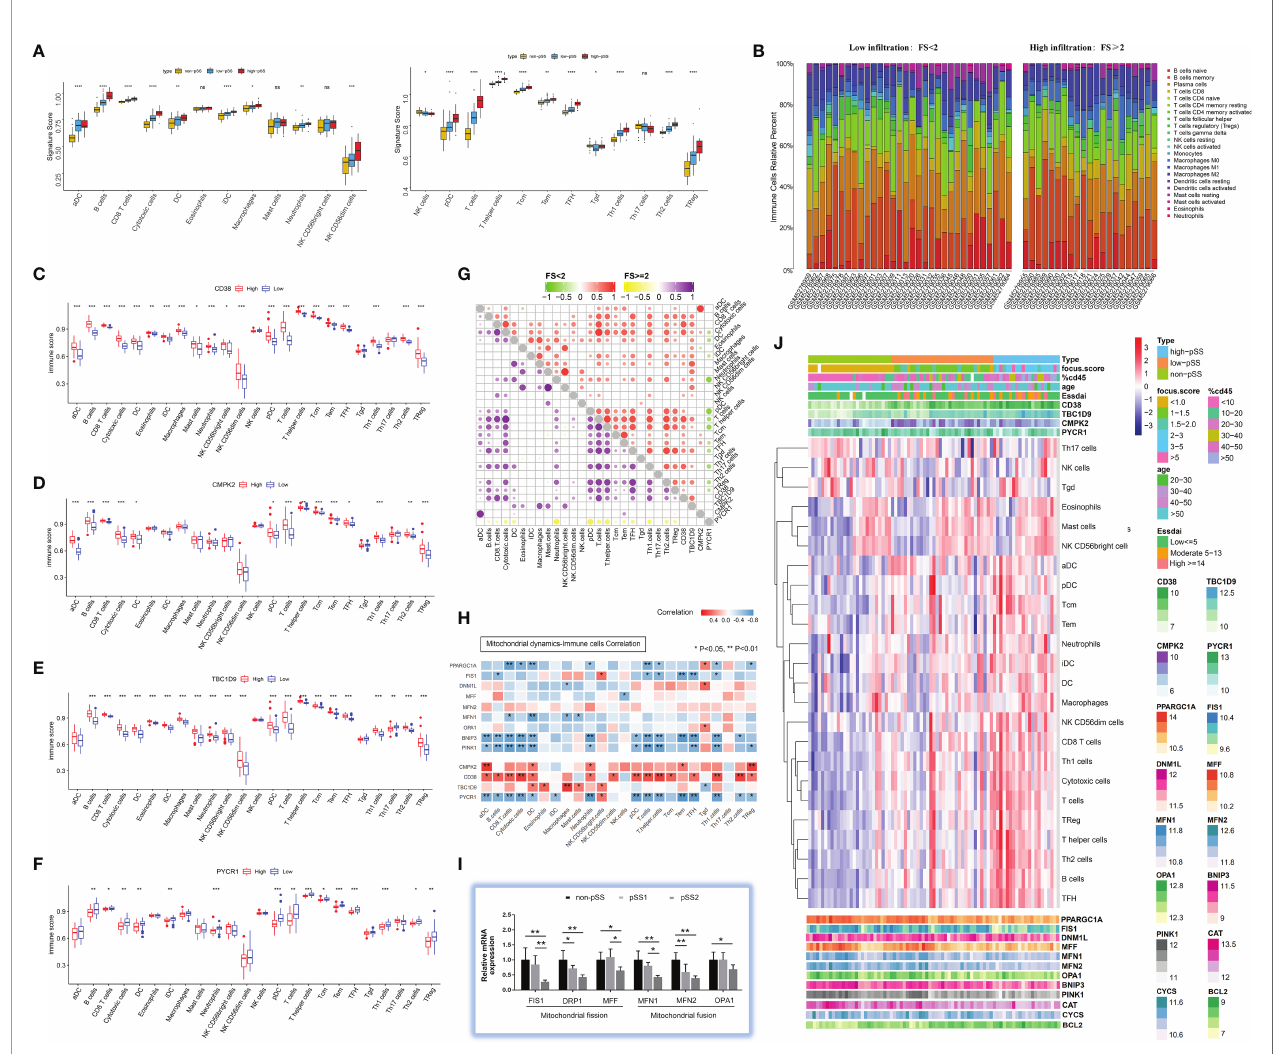
FIGURE 4 | Characterization of immune in fi ltration in salivary glands in pSS. (A) Boxplot of the normalized signature score based on single-sample gene set enrichment analysis (ssGSEA) in the validation cohort. The yellow boxplot represents non-pSS patients, the blue boxplot represents low-in fi ltration pSS patients, and the red boxplot represents high-in fi ltration pSS patients. ***p <0.001, **p < 0.01, *p < 0.05, ns = 1 (independent sample Kruskal – Wallis test). (B) Comparisons of immune-cell proportion between pSS-low-in fi ltration and pSS-high-in fi ltration groups in the validation cohort. (C – F) Comparison of 24 immune cell in fi ltration for CD38 (C) , CMPK2 (D) , TBC1D9 (E) , and PYCR1 (F) high-expression groups versus low-expression group. (G) Spearman correlation between 4 hub genes (CD38, CMPK2, TBC1D9, and PYCR1) and 24 immune cells in pSS-low-in fi ltration and pSS-high-in fi ltration groups. (H) Correlation between interested genes (4 hub genes and mitochondrial dynamic-related genes) and 24 immune cells in pSS patients. (I) The expression pro fi le of genes regulating mitochondrial dynamics was evaluated by quantitative real-time PCR from our own cohort. Data shown are normalized to Actin expression and are relative to expression in the non-pSS (n = 3, error bars represent mean ± SD). *p < 0.05, and **p < 0.01 by Student ’ s t test. (J) Heatmap shows the enrichment scores of interested genes (4 hub genes and mitochondrial dynamic-related genes) and immune cells in pSS samples. Each column represents an individual patient sample, and each row represents a gene or an immune cell, ordered by unsupervised hierarchical